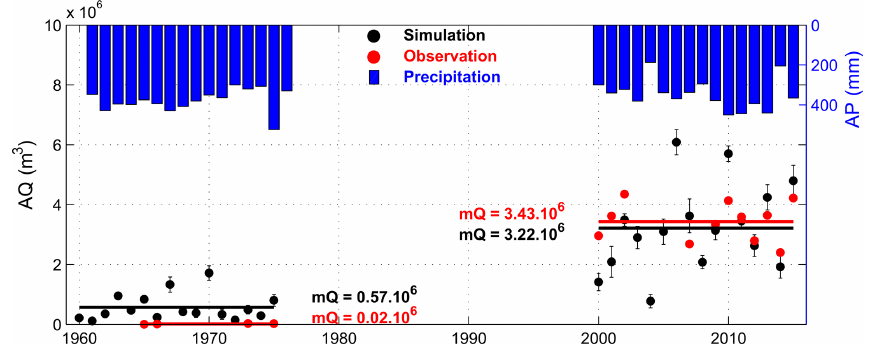
Figure 6. Evolution of annual discharge (AQ, in m 3 ) between 1960 and 2015: simulations with standard deviation of the 10 members (black dots with error bar) and observations (red dots) together with annual precipitation (AP, in mm, blue bars).